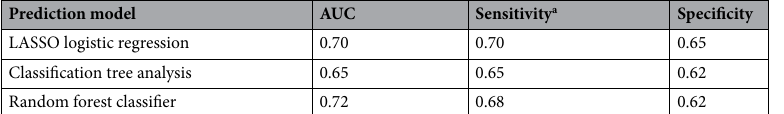
Table 2. The performance of the three machine learning models at predicting graft detachment in the test dataset. AUC area under the curve, LASSO least absolute shrinkage and selection operator. a Sensitivity measures the proportion of detachments that are correctly predicted as detachments.